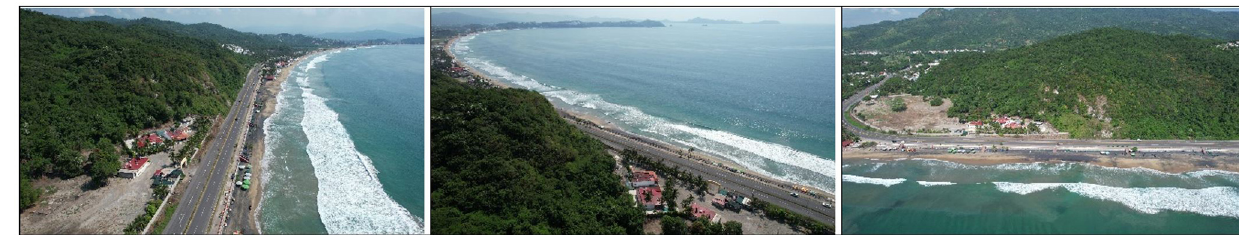
Figure 3. Aerial views of Boulevard Miguel de la Madrid.